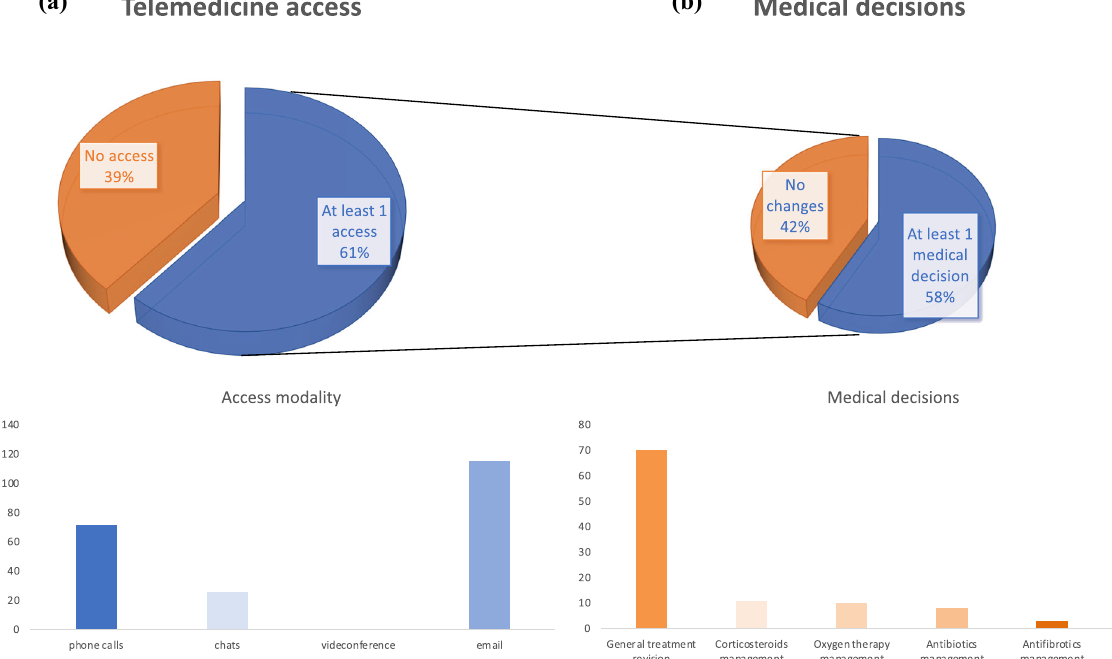
Figure 1: ( a ) Patients who accessed TMS and access modality. ( b ) Outcome of the accesses performed and medical